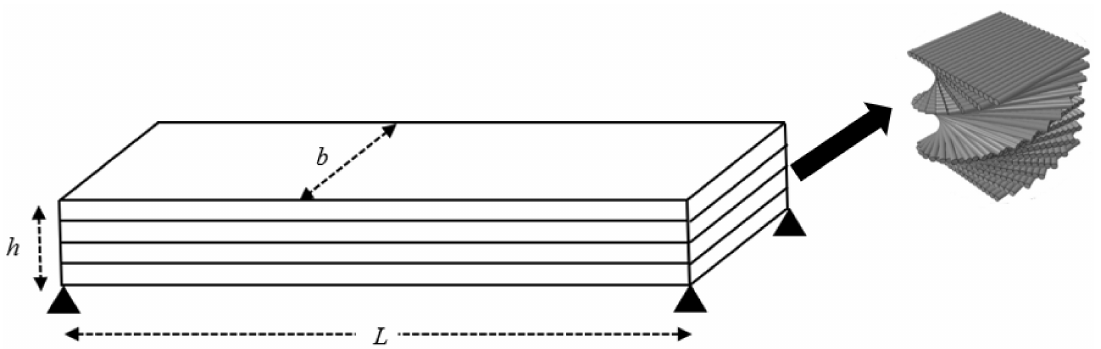
Figure 1. The geometrical presentation of the simply supported helicoidal composite laminated